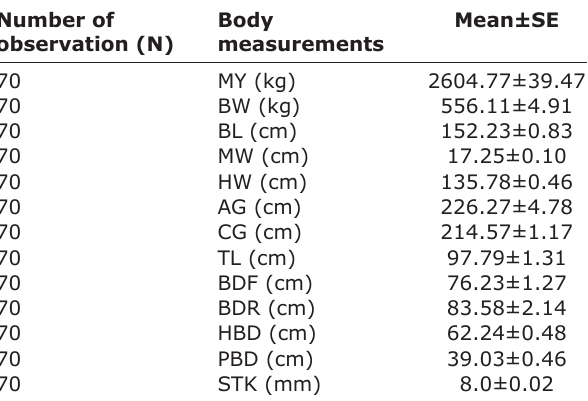
Table-1: Mean of different body parts measurements along with